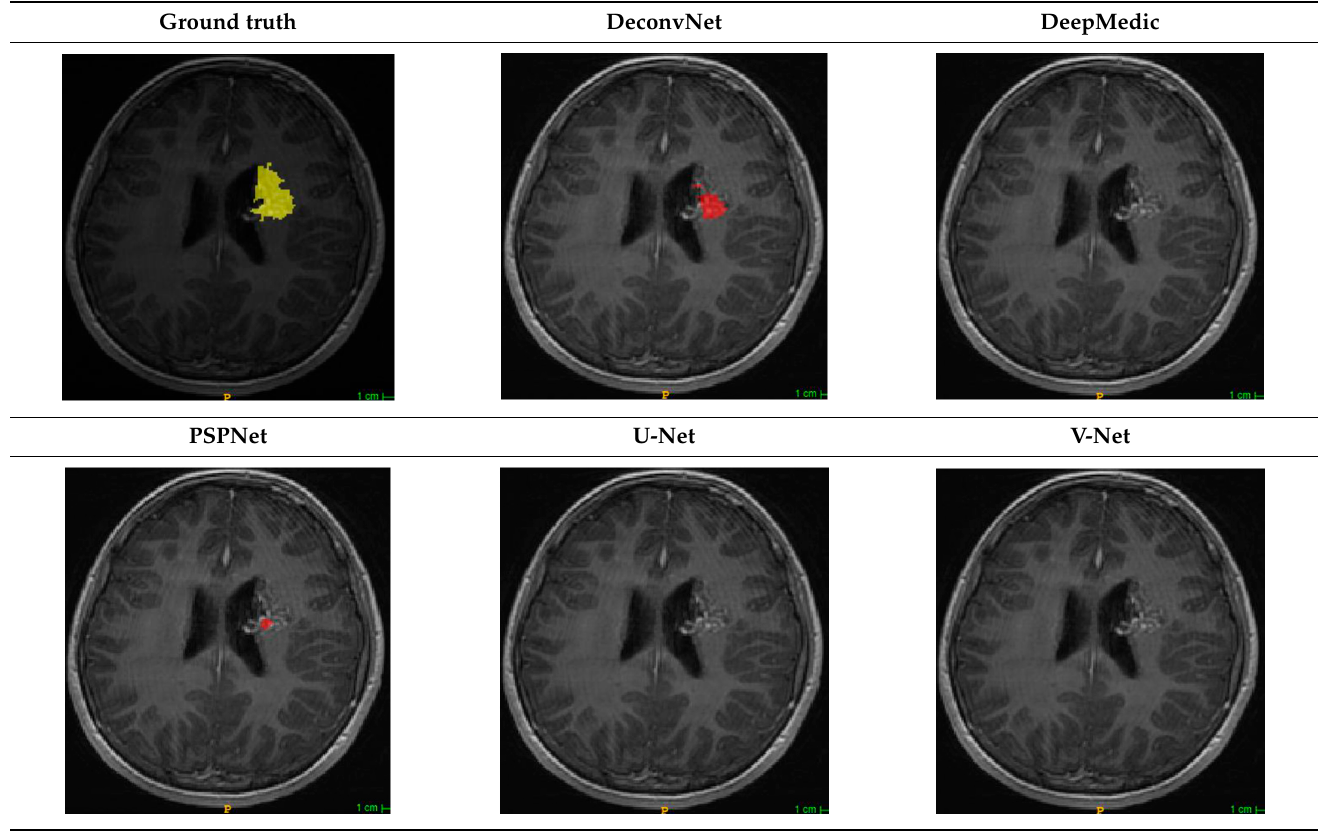
Table 2. Predictions with low dice scores.